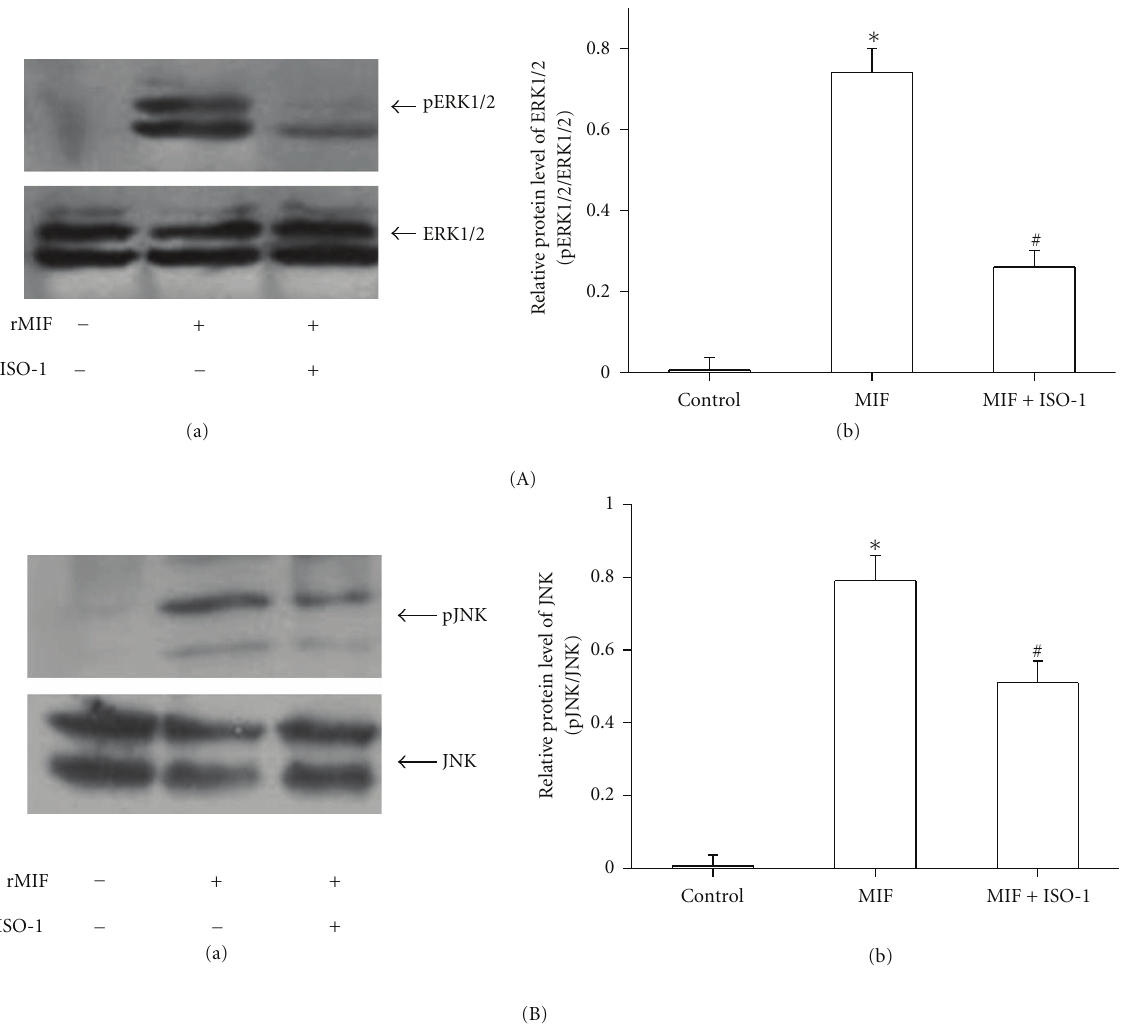
Figure 7: E ff ects of MIF inhibition on phosphorylation of ERK1/2 and JNK in rat PASMCs. MIF-stimulated ERK1/2 and JNK phosphorylation for 60 min was inhibited by MIF antagonist ISO-1 (50 μ M). (A) Cell lysates were analyzed by immunoblotting using antibodies specific for phospho-ERK1/2 (p ERK1/2) and total ERK1/2 (a). Bar graph showed ERK1/2 protein levels obtained from quantitative densitometry analysis (b). (B) Cell lysates were analyzed by immunoblotting using antibodies specific for phospho-JNK (p JNK) and total JNK (a). Bar graph showed JNK protein levels obtained from quantitative densitometry analysis (b). n = 6. ∗ P < 0 . 05 versus vehicle-treated control; # P < 0 . 05 versus groups treated with MIF